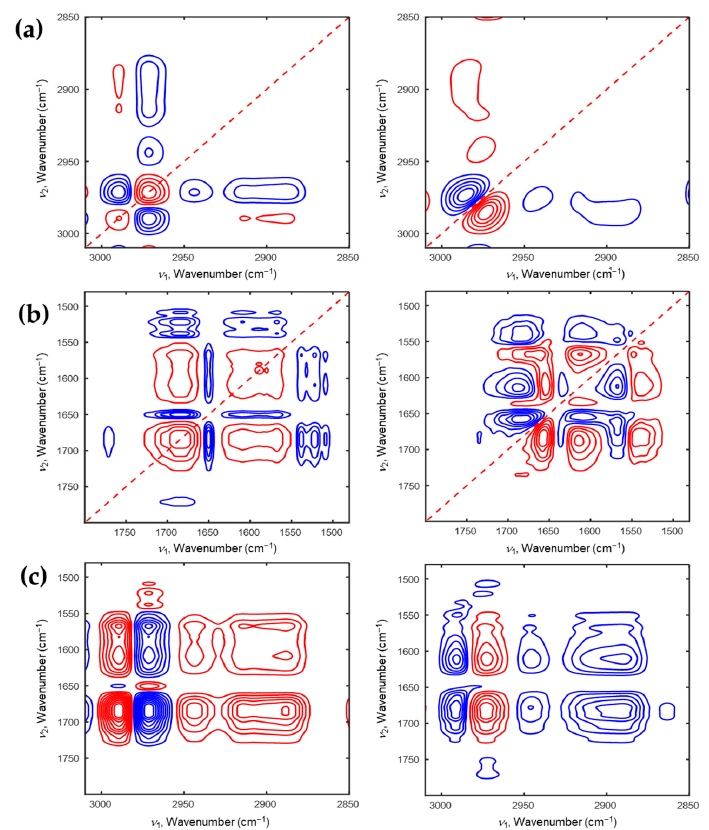
Figure 4. 2D correlation spectra of P(NiPAAm- co -AAc) hydrogel of pH4 during the cooling process ( a : 3010–2850 cm − 1 , b : 1800–1480 cm − 1 ). Hetero-mode 2D correlation spectra ( c ) of P(NiPAAm- co -AAc) hydrogel during the cooling process for the 3010–2850 cm − 1 and 1800–1490 cm − 1 regions.